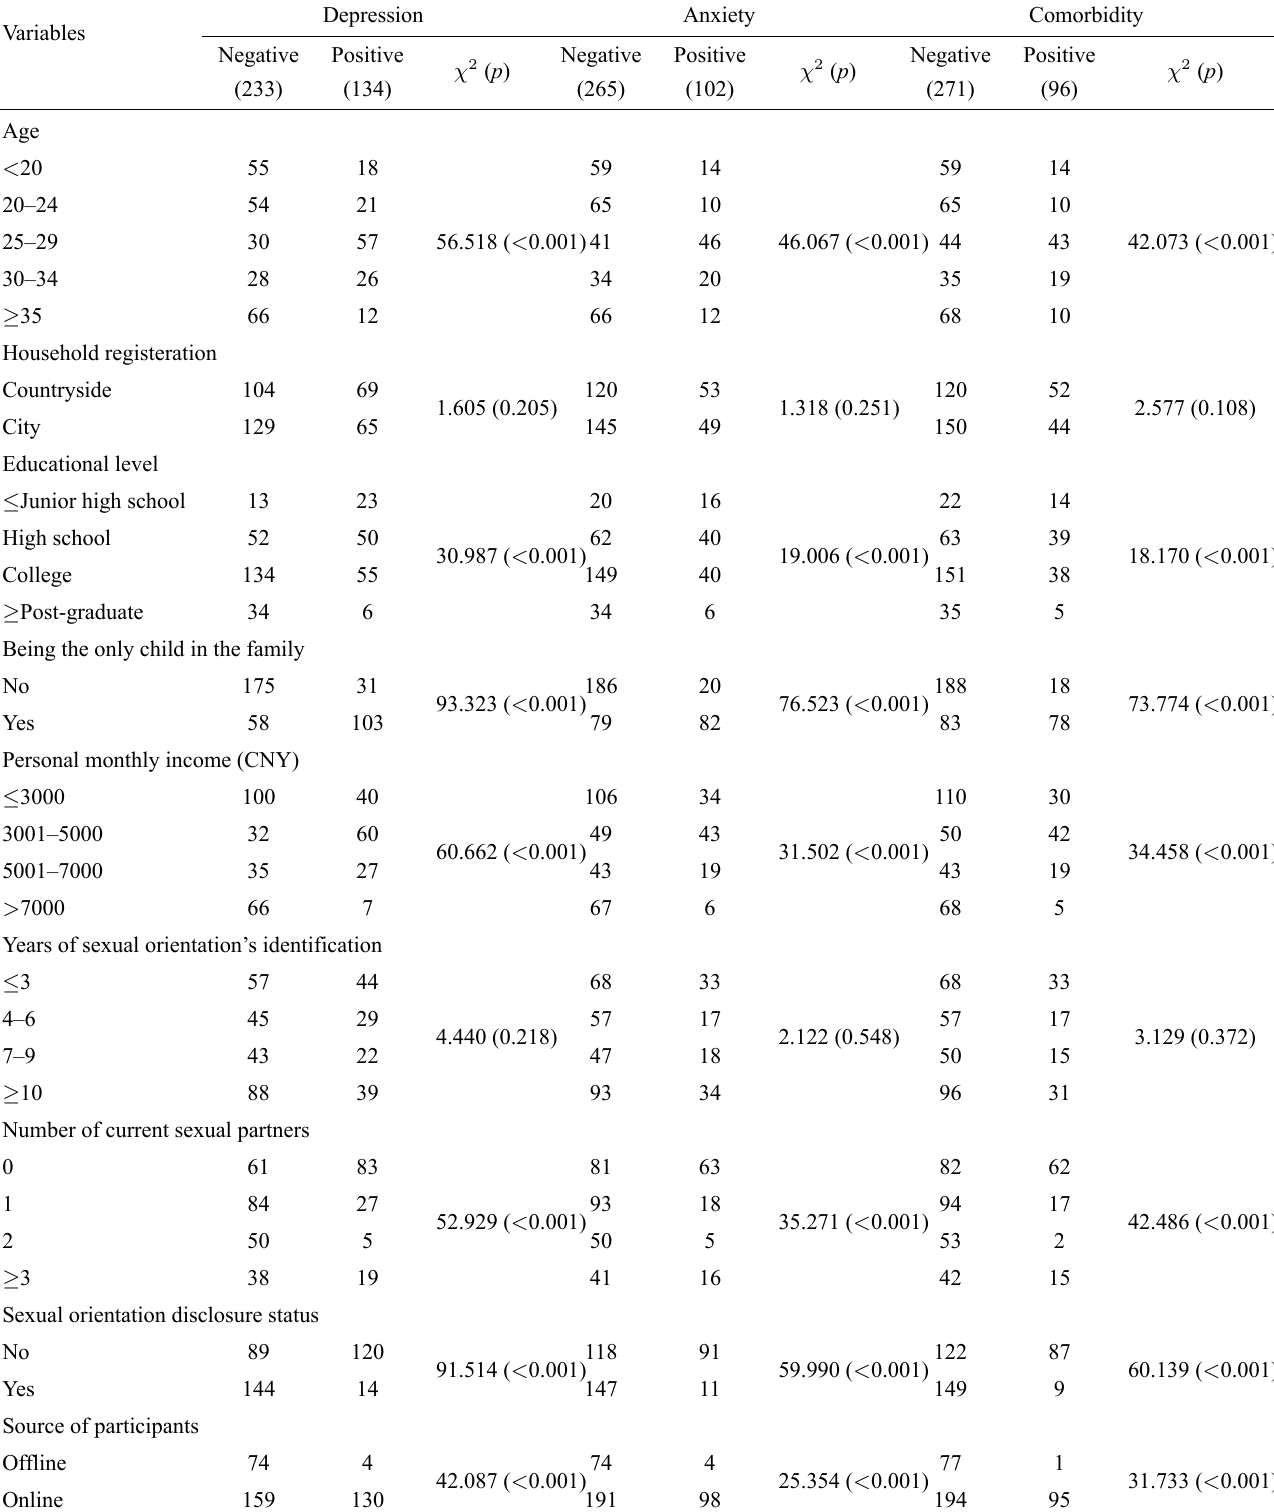
Table 2. Demographics vs. participants who suffered from depression, anxiety and the comorbidity of the two disorders.